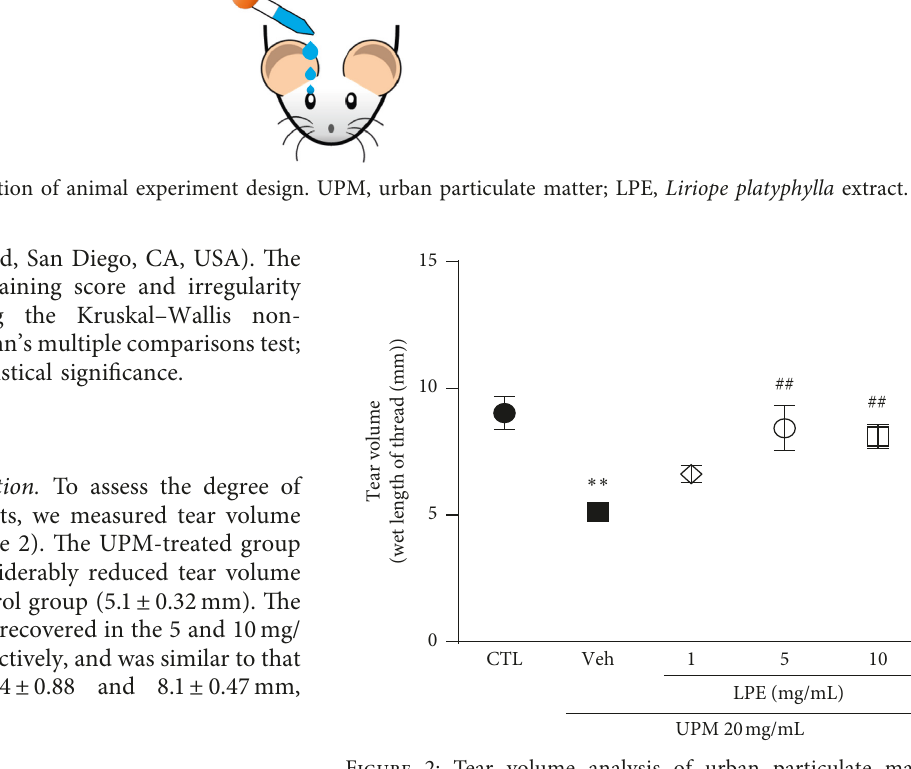
Figure 2: Tear volume analysis of urban particulate matter (UPM)-induced dry eye syndrome (DES) with and without Liriope platyphylla extract (LPE) treatment (1, 5, and 10 mg/mL). CTL, Control; Veh, Vehicle. Data shown are mean ± standard error. ∗∗ p < 0 . 01 vs. Control; ## p < 0 . 01 vs. Vehicle.